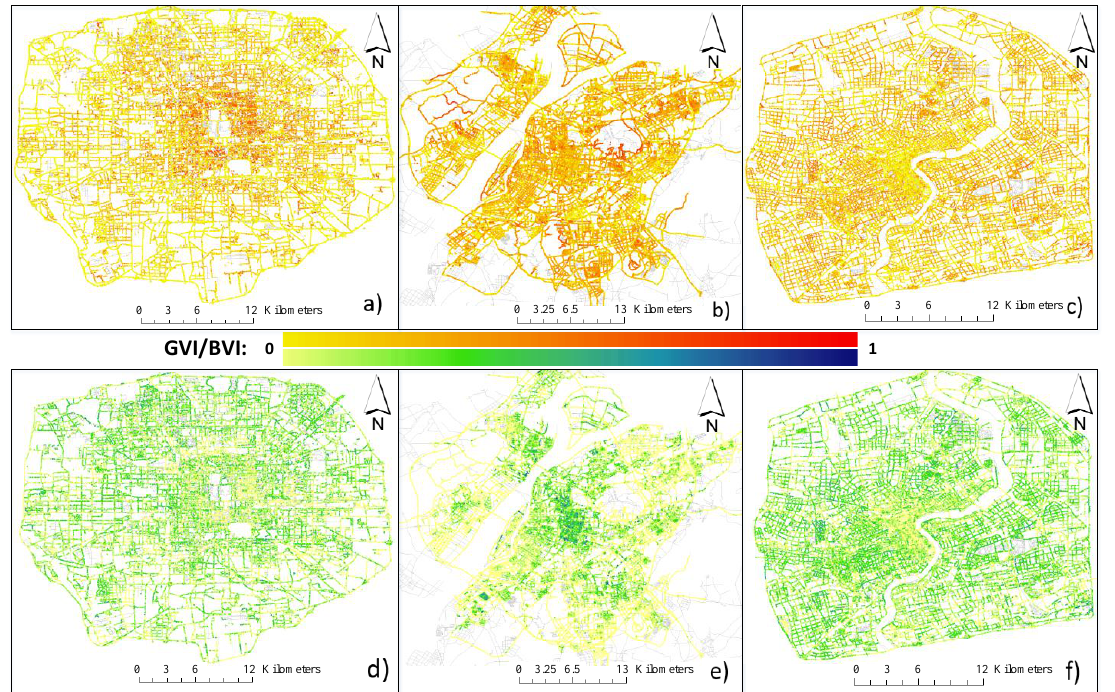
Figure 4. The results of street view image segmentation.